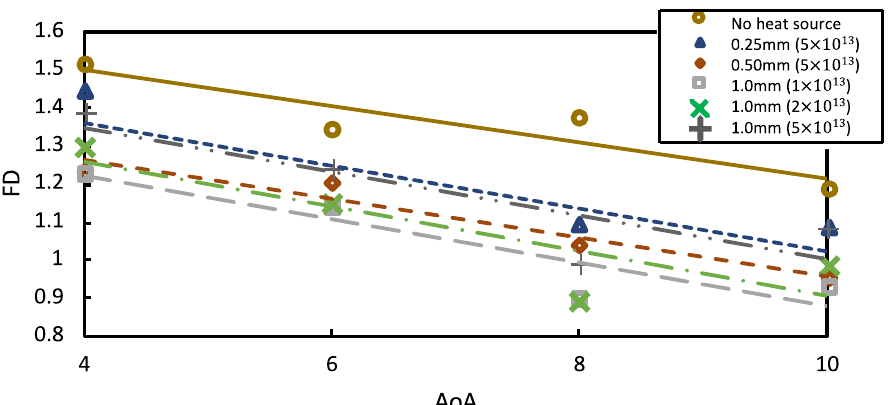
Figure 7. Flow distortion in steady-state conditions at various diameters and powers of heat source.